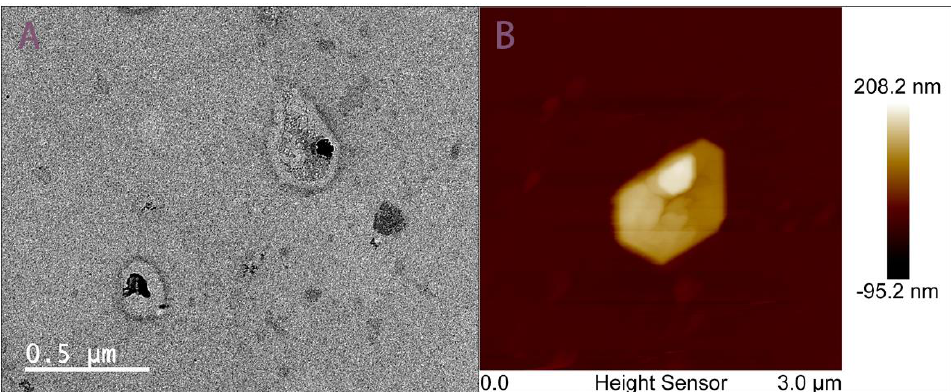
Figure 3 . TEM and AFM imaging of exosomes isolated by aptamer-based microfluidics. ( A ) TEM image of EVs isolated by microfluidics presents a distorted cup-shaped morphology and uniform unimodal size distribution following 200 nm filtration. ( B ) AFM image EVs isolated by microfluidics presents a distorted cup-shaped morphology.